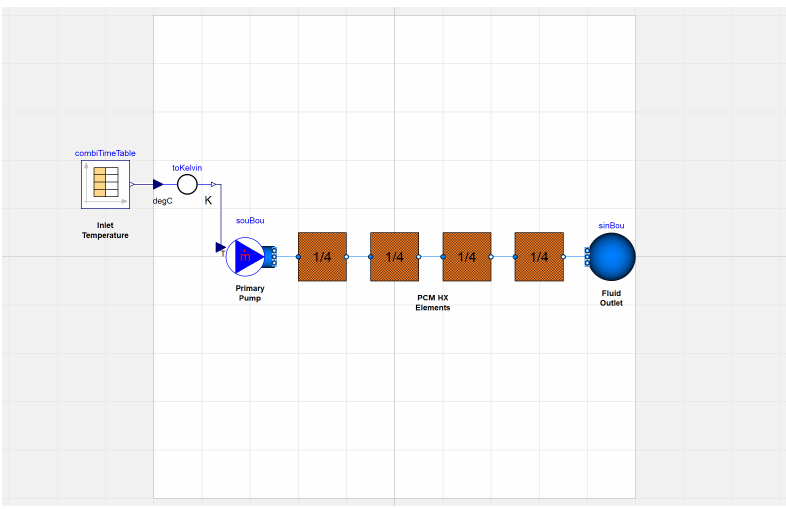
Figure 2. Preliminary model of the thermal energy storage test rig in